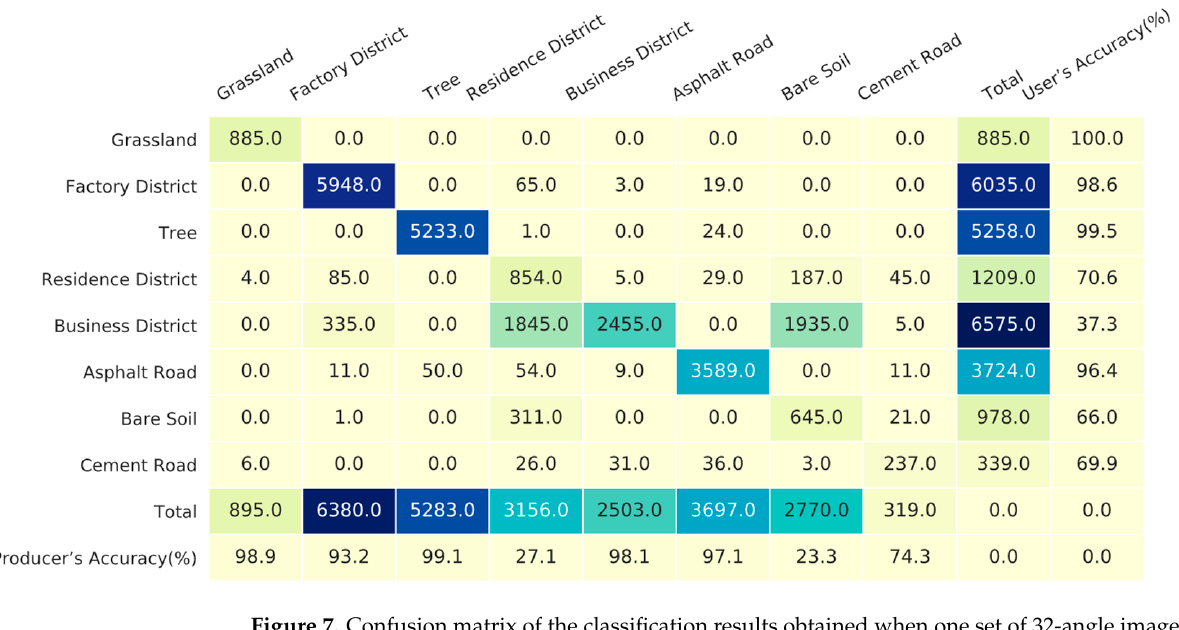
Figure 7. Confusion matrix of the classification results obtained when one set of 32-angle images was employed as the input data.